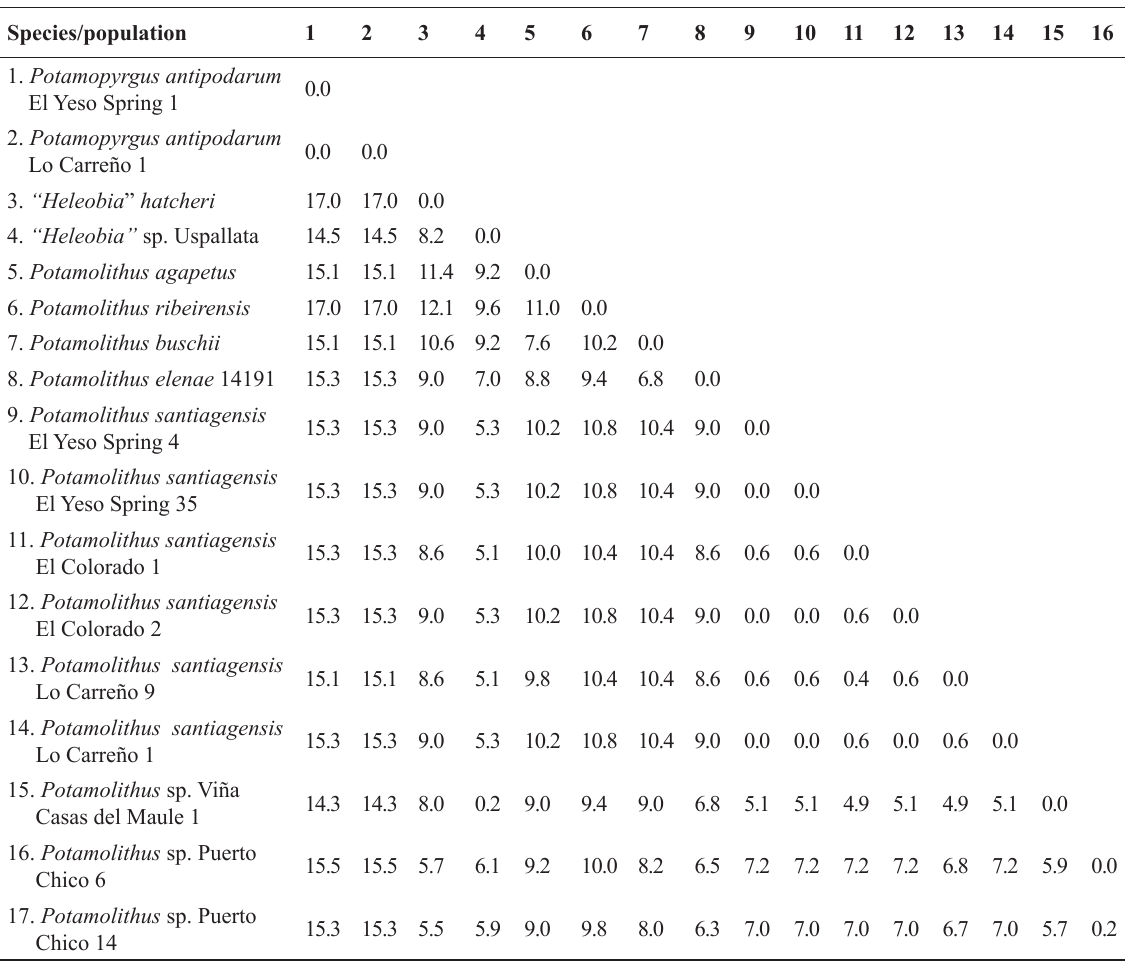
Table 3. Percent of mean sequence variation (based on p-distance) of COI data among South American species/populations belonging to the